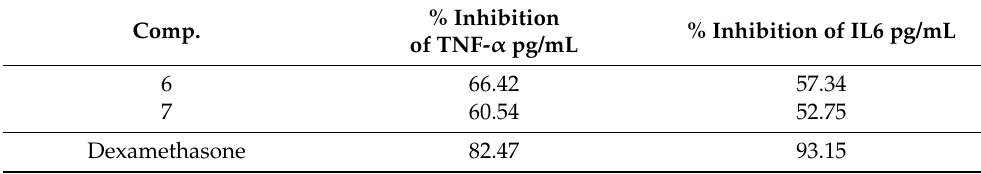
Table 4. The inhibition (%) of TNF ‐α and IL6 in HCT ‐ 116 cells after compounds’ 6 and 7 treatment. Comp.